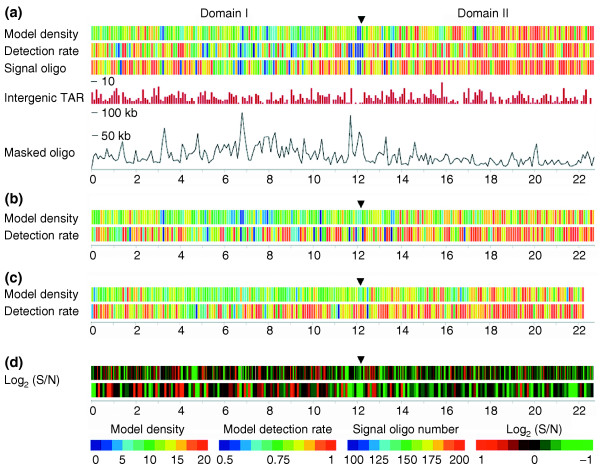
Rice chromosome 10 gene model distribution and expression. (a) Characterization of TIGR nonredundant protein-coding gene models. Model density, array detection rate, number of signal oligos, number of intergenic TARs, and cumulative length (in kilobases) of masked oligos are calculated in 100-kb windows along the length of chromosome 10, and are represented by color-coded vertical bars. A scale representing the physical length of chromosome 10 is shown at the bottom of the panel. The arrowhead delimits the division of domain I and domain II as indicated in the text. Note that the centromere is located at a position around 7 to 8 Mb in chromosome 10. (b) Gene model density and array detection rate of the BGI japonica annotation. (c) Gene model density and array detection rate of the BGI indica annotation. (d) Comparison of the S Arrays and the N Arrays using the BGI japonica annotation. Log2 (S/N) of the hybridization intensity was calculated for individual models (top) and the mean intensity of all models in 100-kb windows along the length of chromosome 10 (bottom).